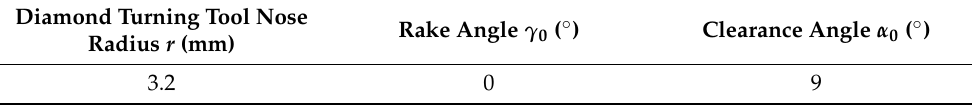
Table 1. The parameters used in SPDT to machine the KDP. Diamond Turning Tool